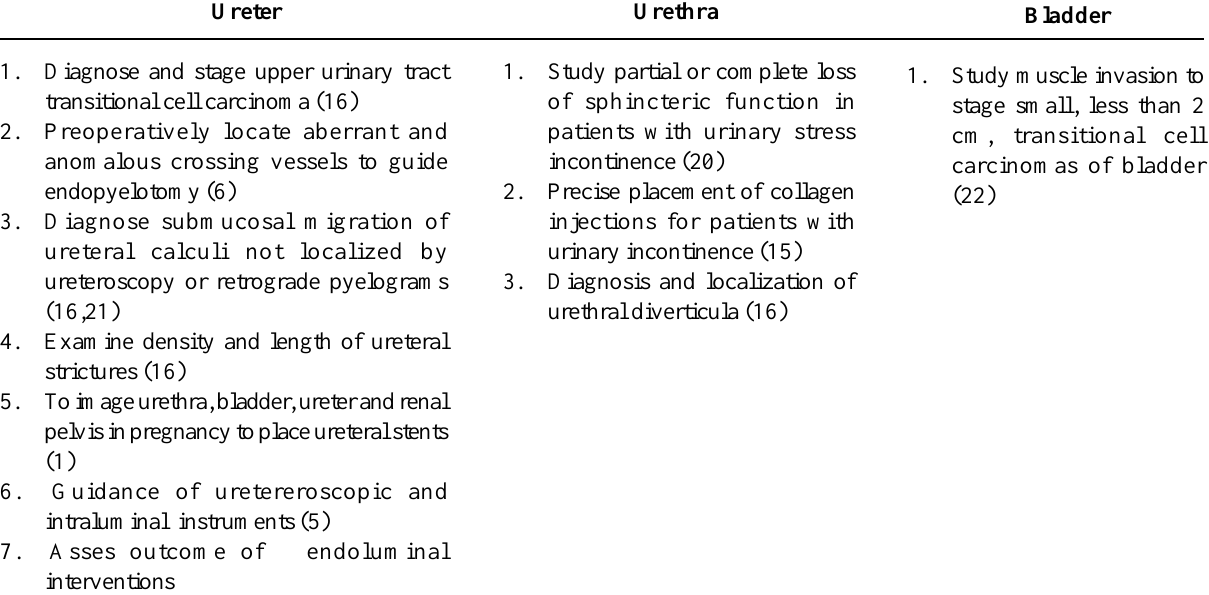
Table 1 – Clinical application of